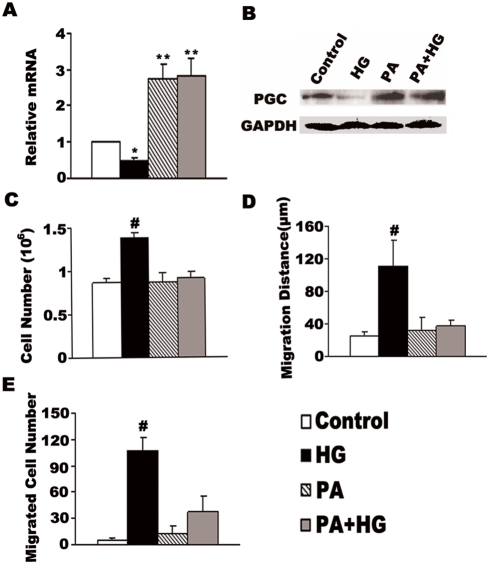
Palmitic acid stimulates PGC-1α expression and retards high glucose-induced VSMC growth and movement.Cultured rat VSMCs in 5.5 mM glucose were either left untreated or stimulated with 15 mM glucose (HG) in the absence and presence of 0.4 mM palmitic acid (PA) for 48 h. PGC-1α expression was determined by real-time RT-PCR (A) and by Western blot with PGC-1 antibody compared with GAPDH antibody, 120 µg total proteins from VSMCs were loaded (B). Cell growth was determined by counting the number of cells (C). Migration distance was determined by a standard wound healing assay (D) and transwell analysis (E). The bars represent means±S.E.M (n = 6). **P<0.01 compared with control conditions, #P<0.001 compared with the control group.